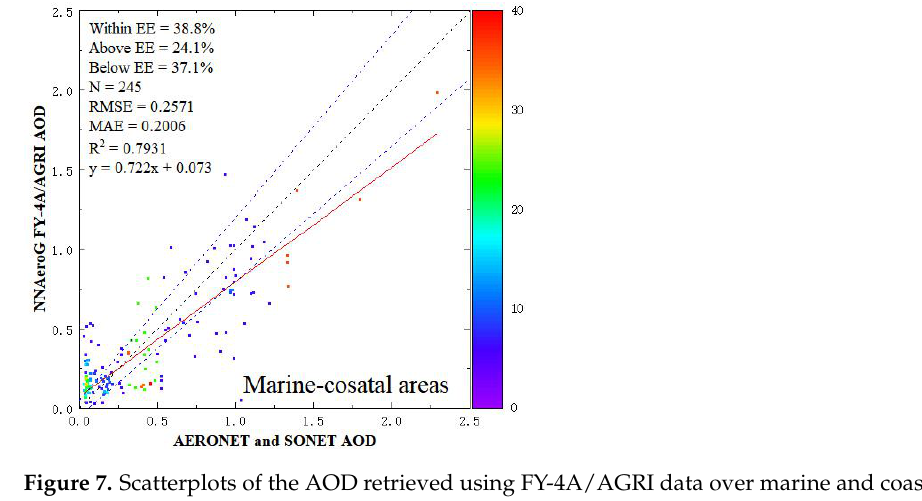
12 of 20 Figure 6. Scatterplots of the AOD retrieved using FY-4A/AGRI over arid areas versus AERONET and SONET reference data. The blue lines are the EE envelopes for AOD of ± (0.05 + 15%). The red line is the linear fitting line of AOD. The black line represents the 1:1 line.